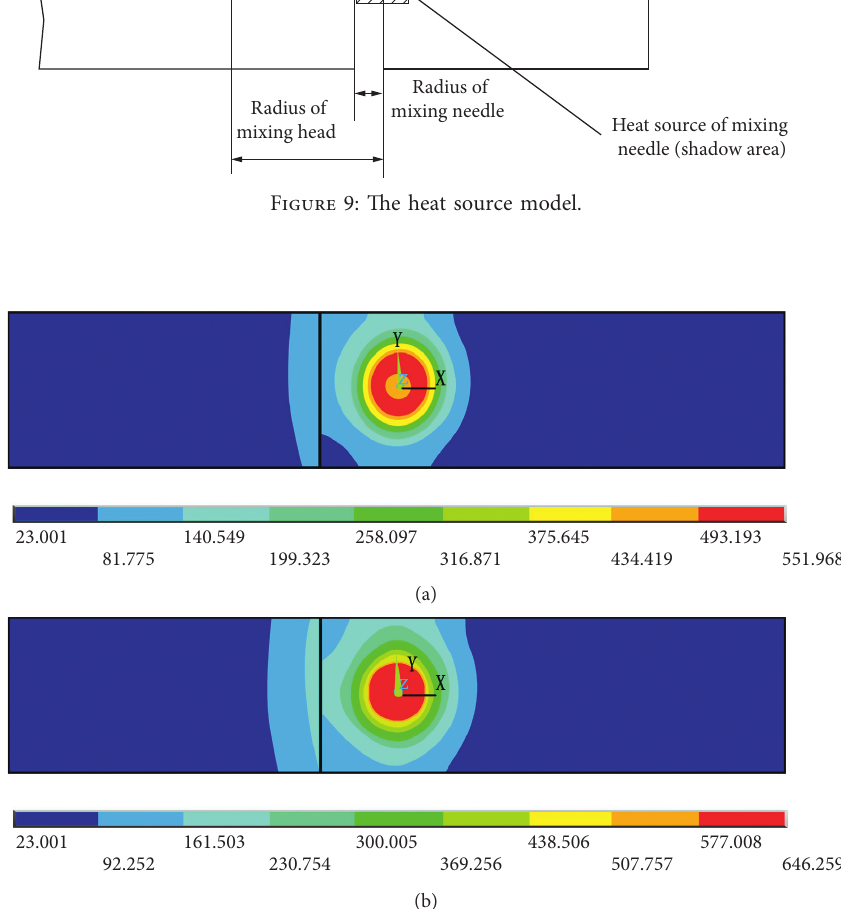
Figure 10: Cloud pictures of temperature distribution corresponding to different dwell times. (a) 60s. (b) 90